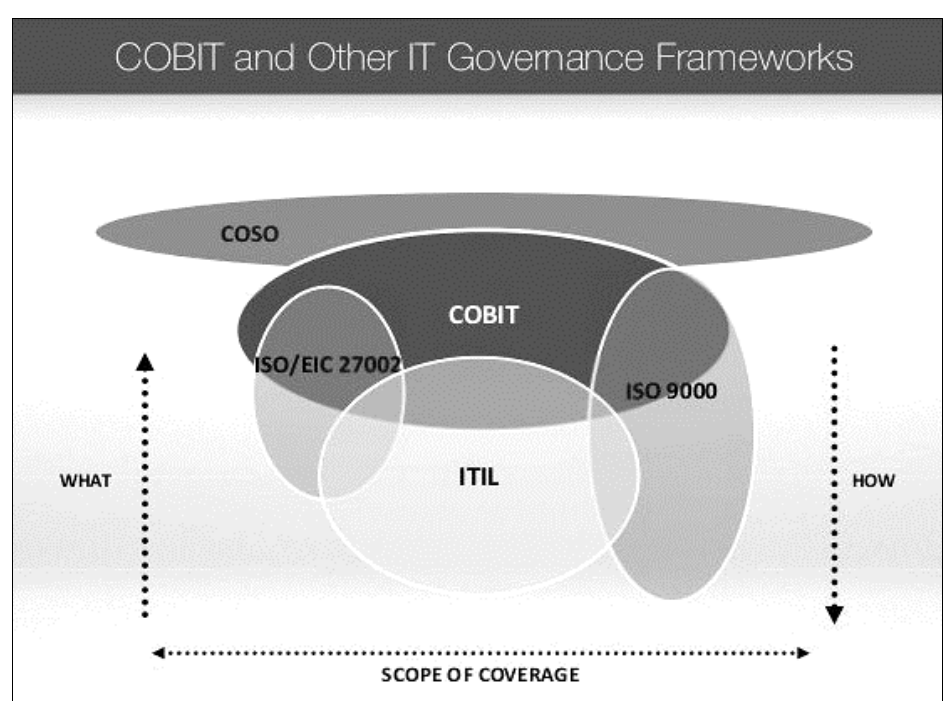
Figure 1. COBIT’s scope and coverage within the generic ecosystem of frameworks and